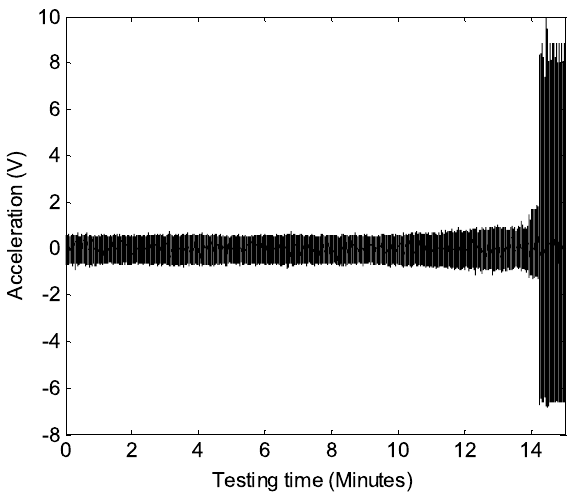
Fig. 6. Complete time history of gear vibration detected until the end of fatigue life of the test